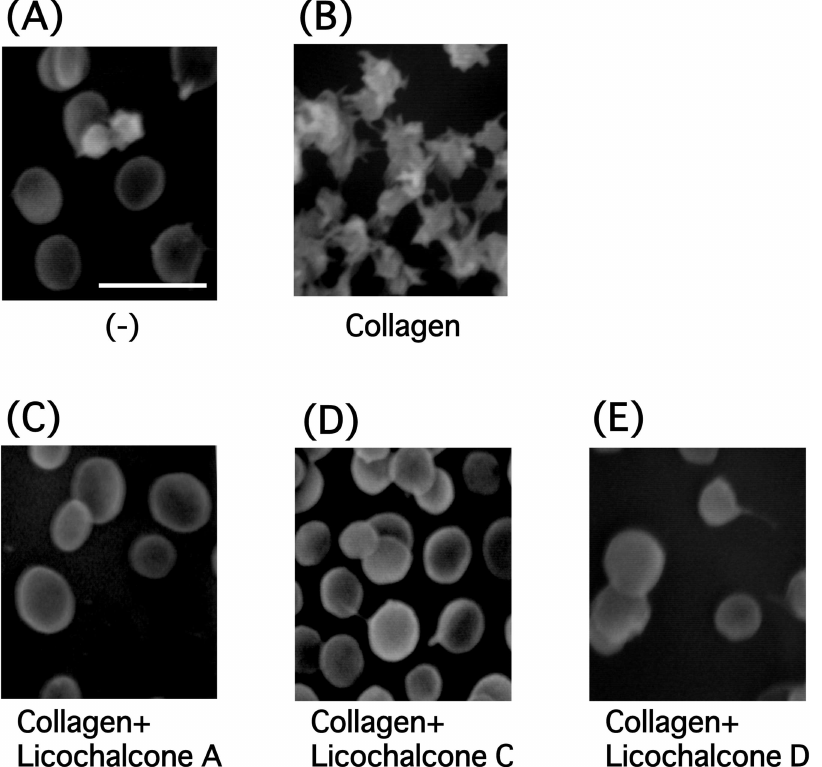
Fig 3. Scanning electron microscopy images of platelets stimulated by collagen in the presenceof licochalcones. Platelets were incubatedwith collagen(3 μ g/ml) for 3 min in the presence or absenceof licochalcones (100 μ M), then fixed overnightwith 1% glutaraldehyde. The samples were washedtwice for 5 min with PBS. The fixed plateletswere dehydrated with ethanoland t-butyl alcohol,and after the samples were freeze-driedand coated with Au/Pd, they were observedunder a scanningelectron microscope. (A) Unstimulated platelets, (B) collagen(3 μ g/ml), (C) licochalcone A (100 μ M) +collagen, (D) licochalcone